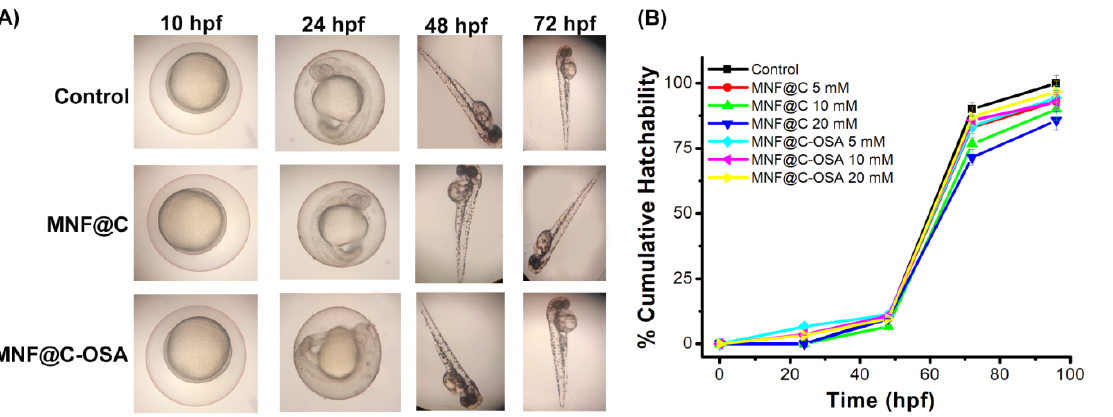
Figure 7. ( A ) Microscopic images of developmental stages of zebrafish embryos at the intervals of 10, 24, 48, and 72 hpf. ( B ) Percent cumulative hatchability of embryos was plotted against hpf, where untreated embryos were taken as controls.